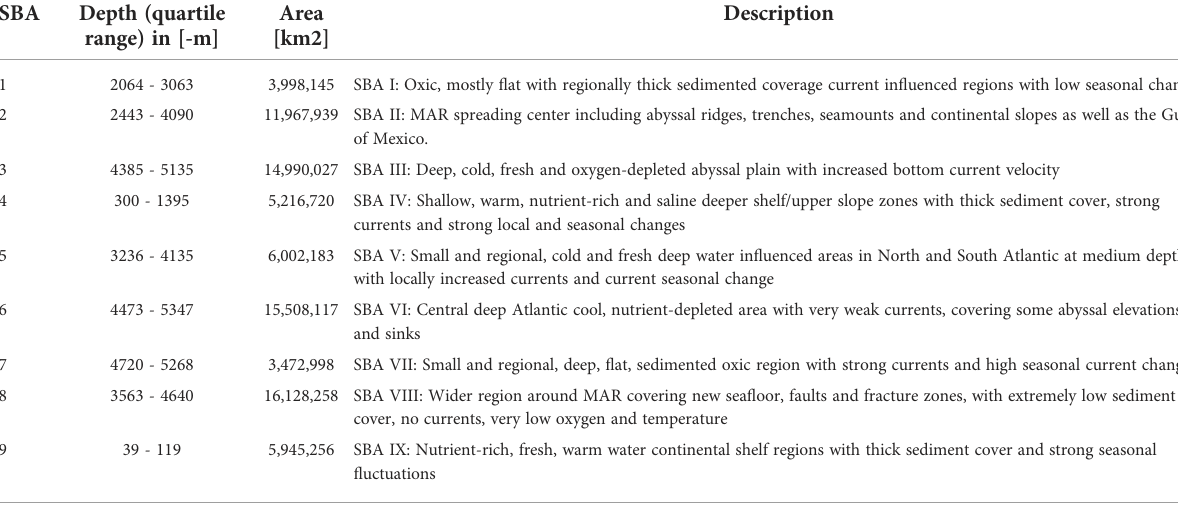
TABLE 1 SBA description summary ordered by area covered (from smallest to largest).